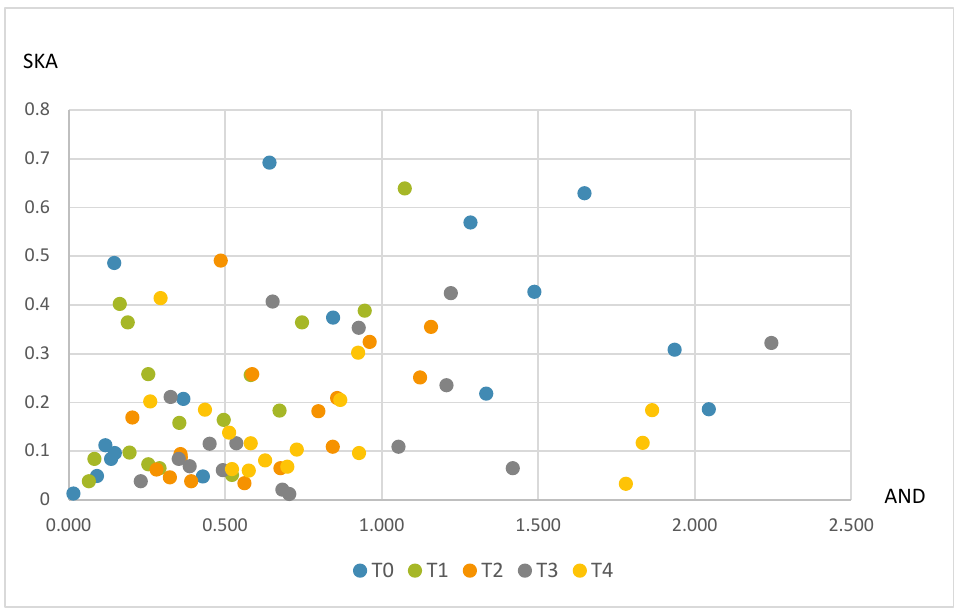
Figure 1. Diversity of androstenone (AND) and skatole (SKA) regarding tannin treatments.